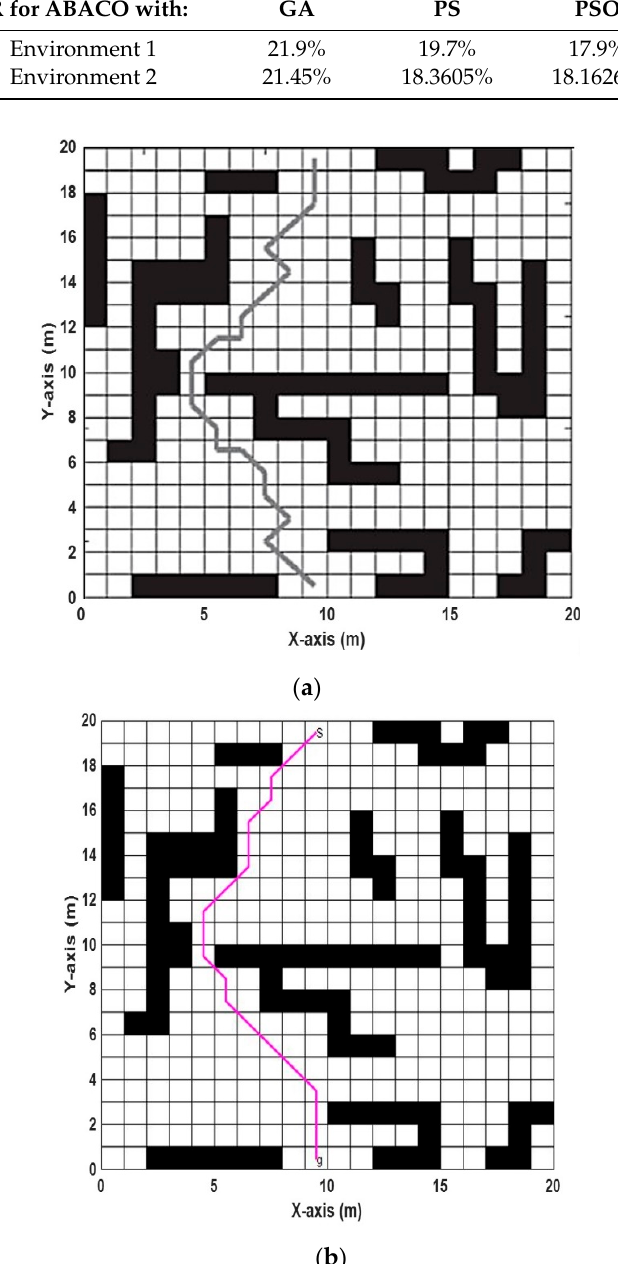
Figure 18. (20 × 20) grid using ( a ) the ABC algorithm and ( b ) the AACO algorithm